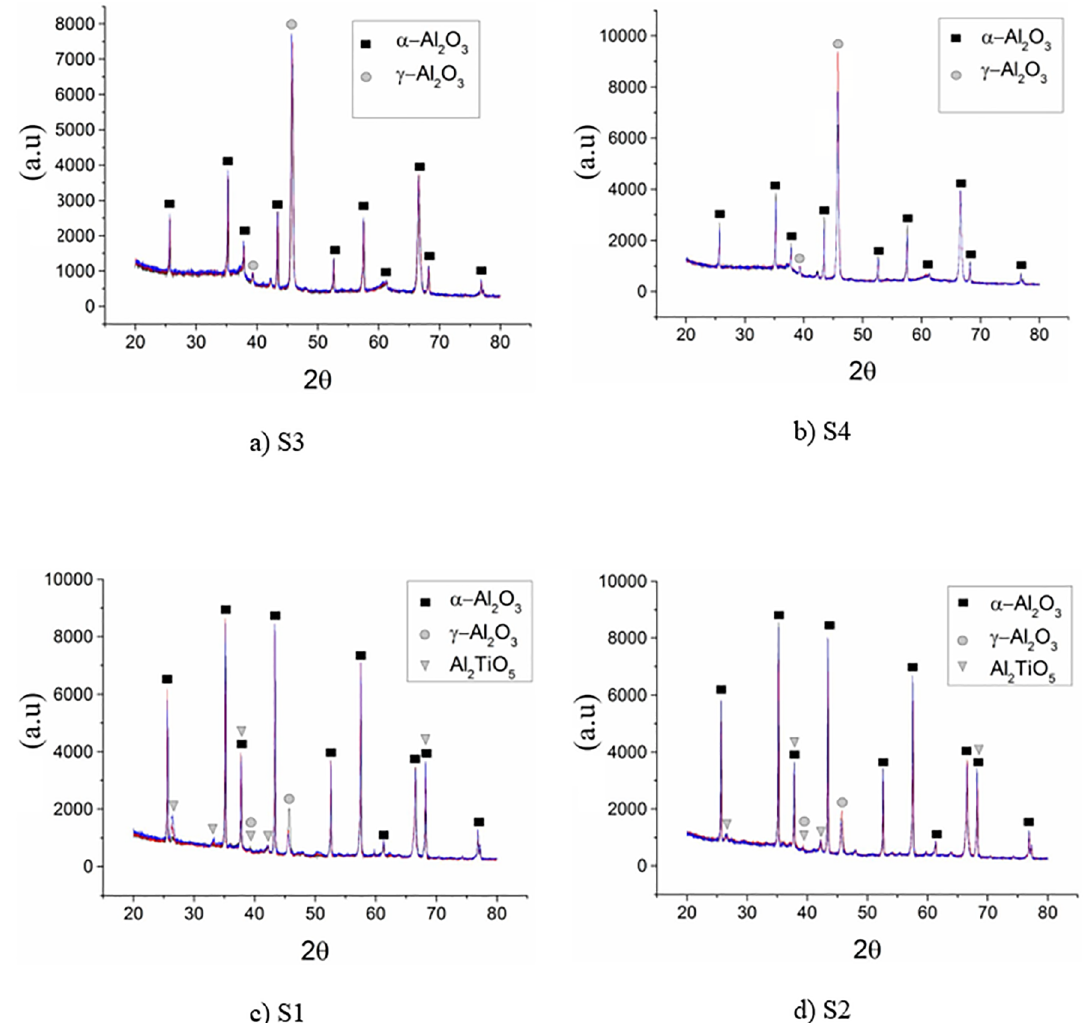
Figure 3. X-Ray diffractograms of AT-13 coatings for several oxygen: acetylene volumetric ratios and spraying distances. a) Coating S3: 1:2.5 - 110 mm, b) Coating S4: 1:2.5 - 140 mm, c) Coating S1: 1:1.7 - 110 mm, d) Coating S2:1:1.7 - 140